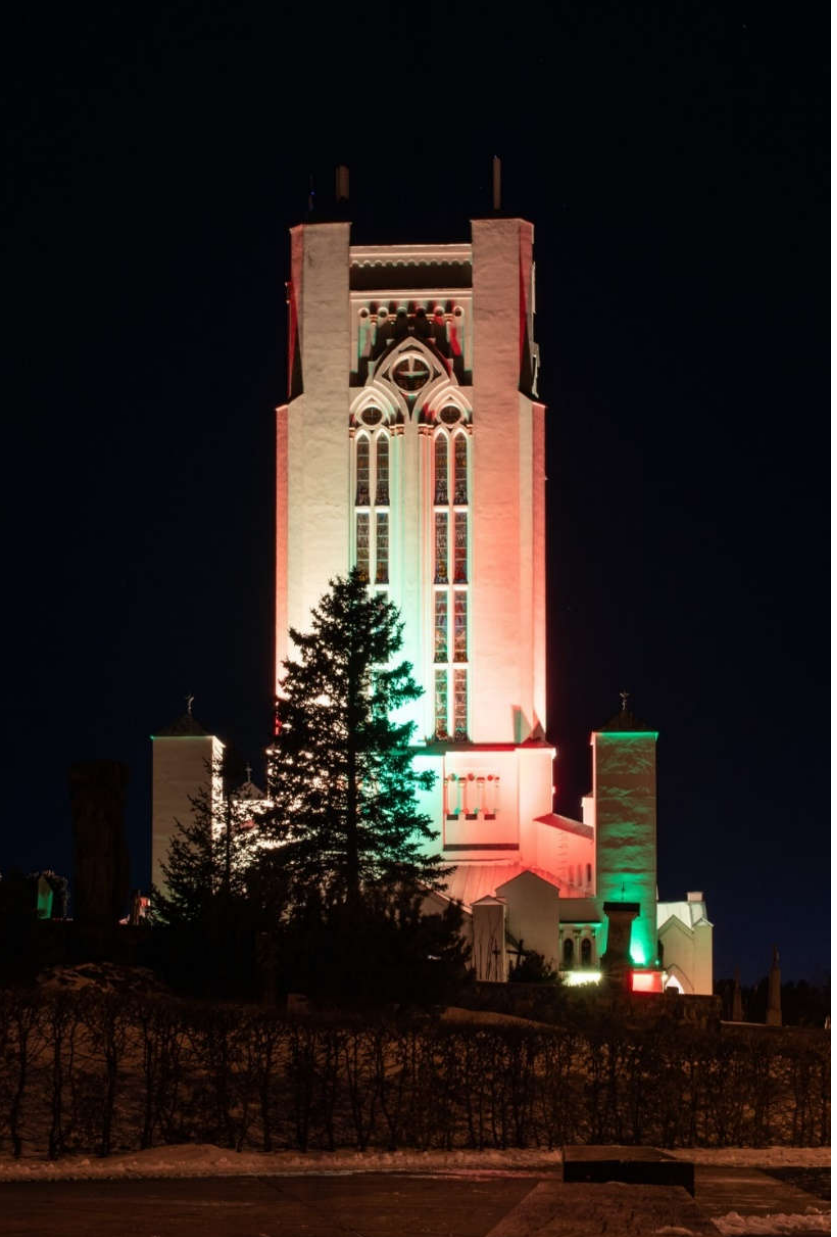
Figure 7. Chapel of the Apparition of Saint Mary in Šiluva. The Chapel, built in 1906 is considered to be architecturally a sign of the early modernism architecture of Lithuania (architect Antanas Vivulskis). Due to financial and political issues, the chapel was completed and consecrated only in 1924. The building managed to grasp timelessness by using traditional architectural forms with futuristic design decisions. Photo by Laima Šili ¯ unait ˙